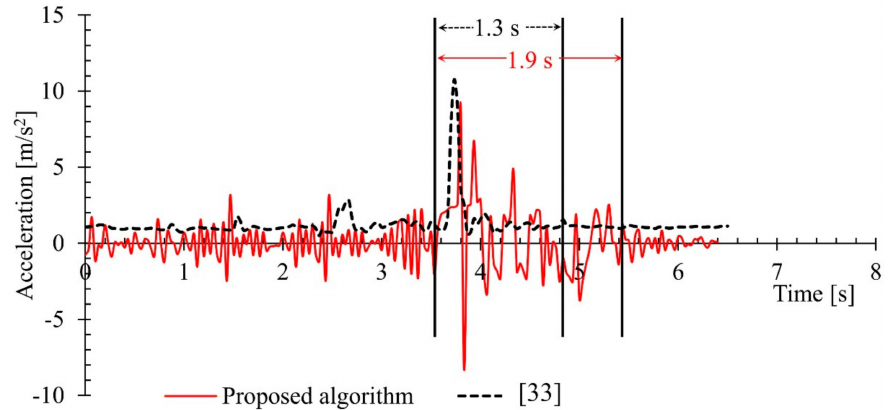
Figure 6. Changes in acceleration for a fall event from the dataset and a similar event from the own simulated activities.